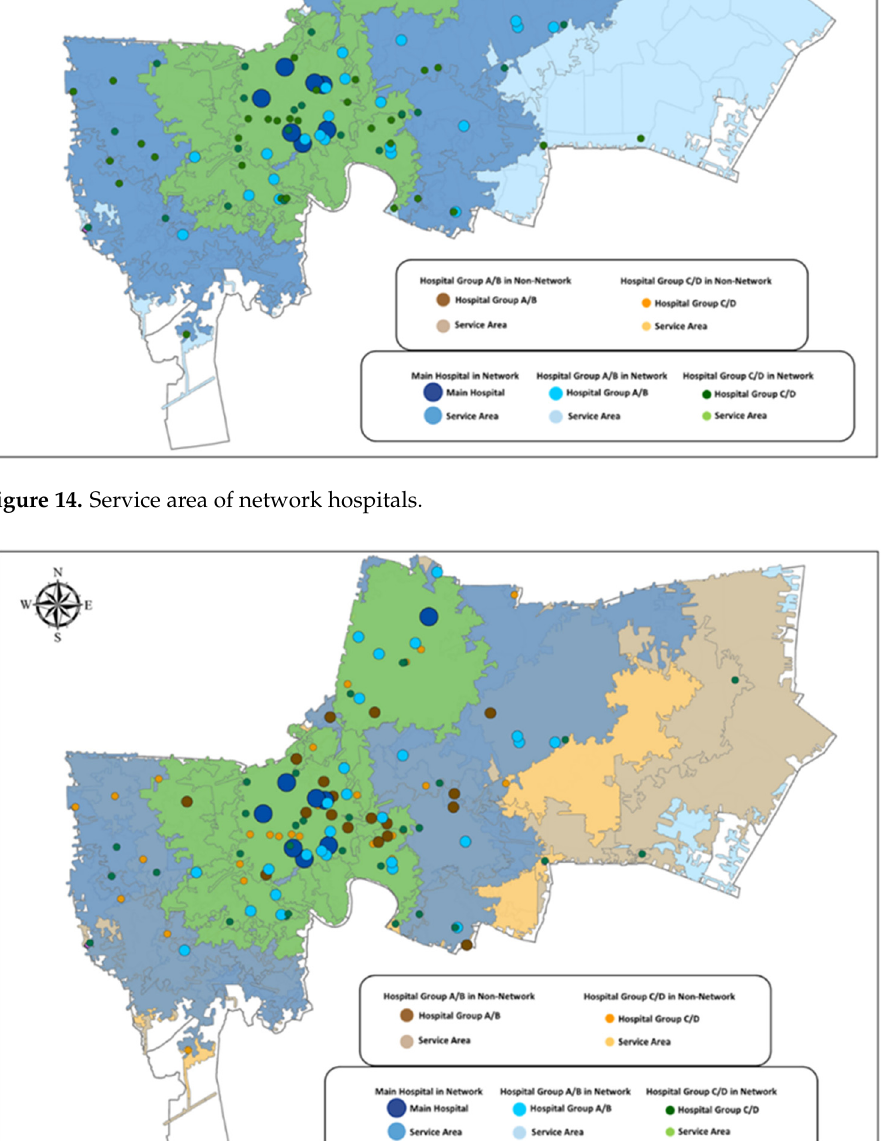
Figure 15. Service area of all hospitals in all models.